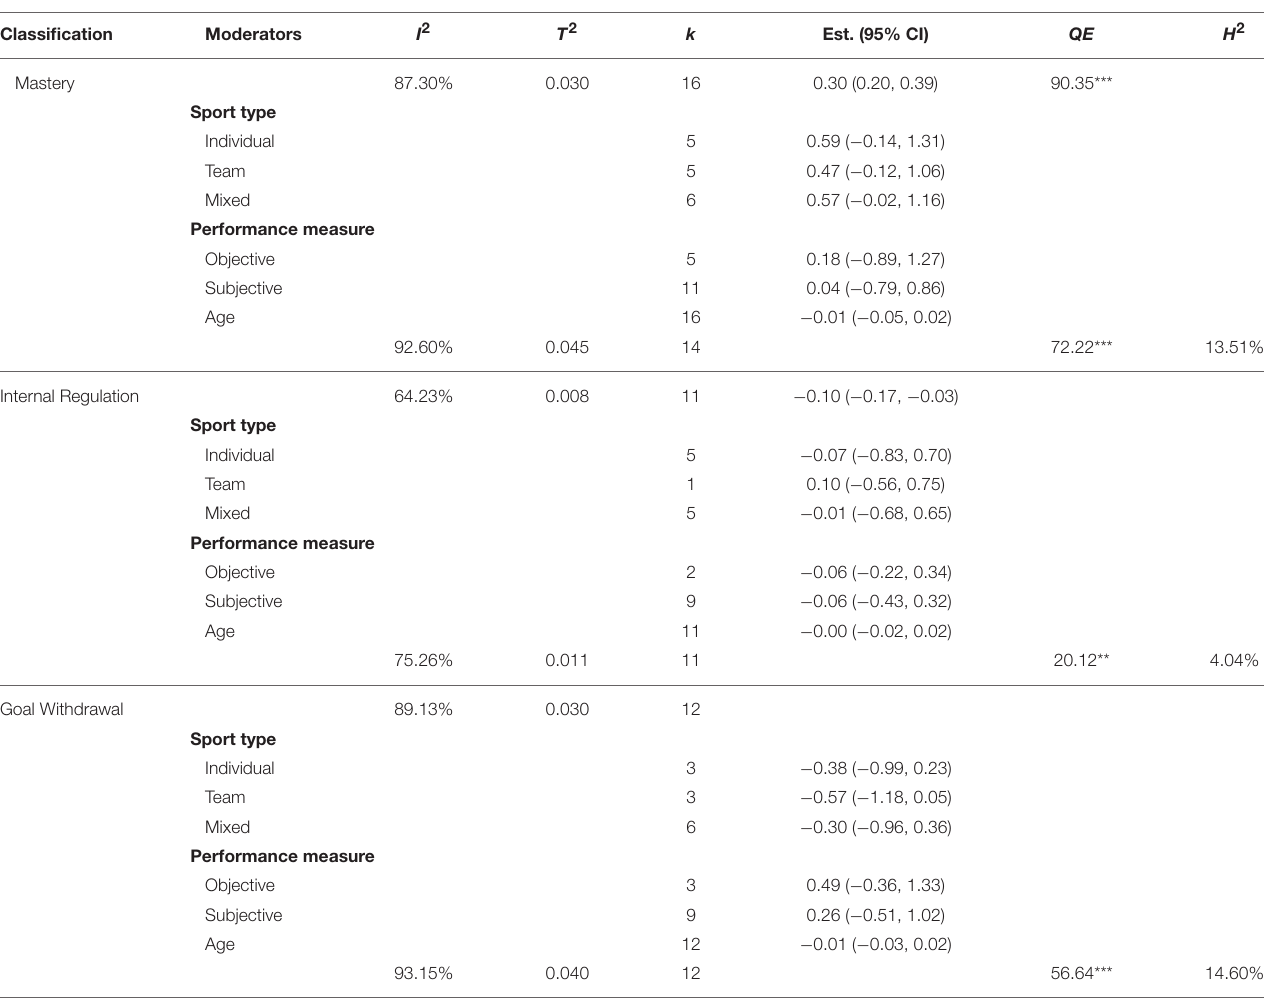
TABLE 3 | Moderator